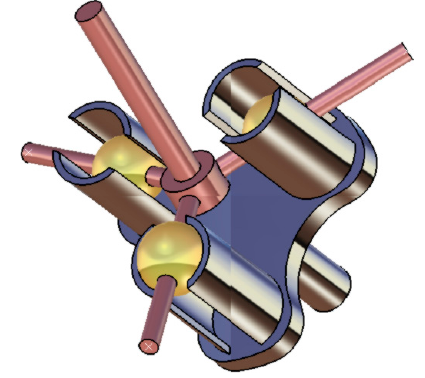
Figure 11. Tripod joint, point–surface contact.